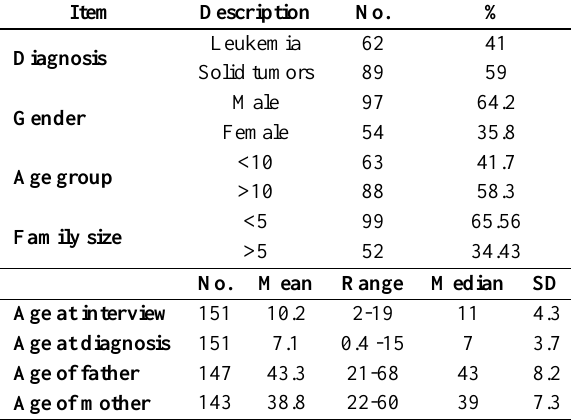
Table 1: Descriptive feature of the 151 patients